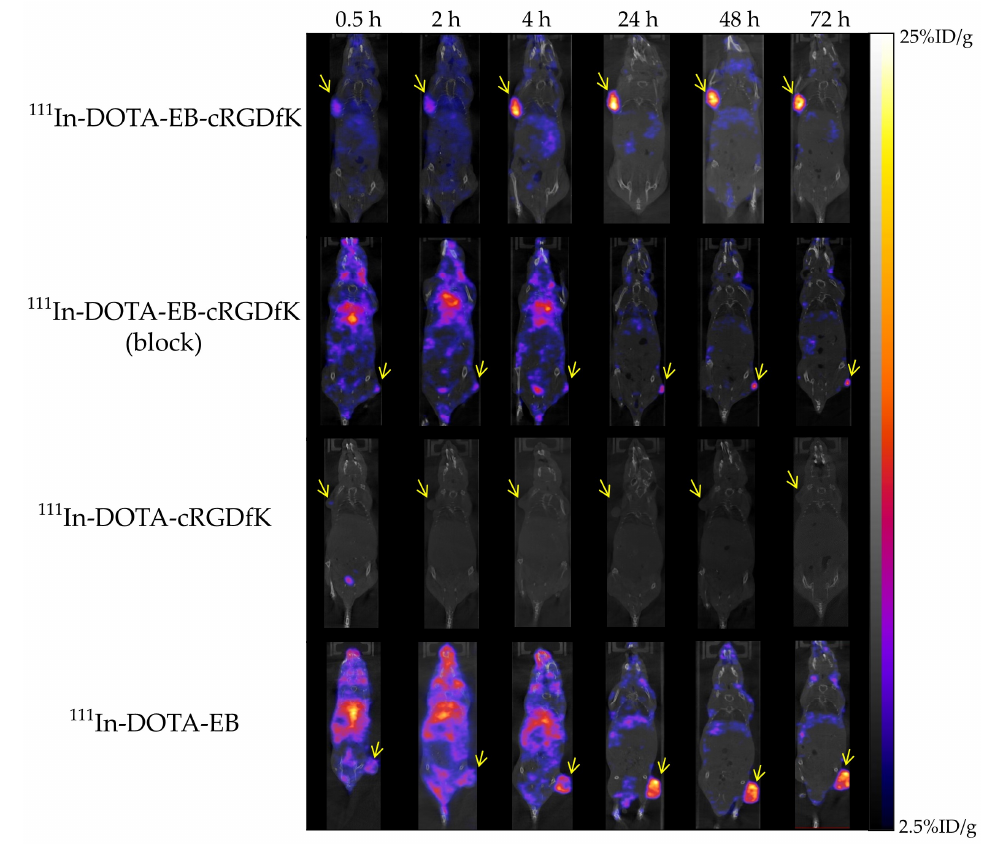
Figure 3. NanoSPECT/CT images of U-87 MG tumor-bearing mice. NanoSPECT/CT images at 0.5, 1, 4, 24, 48 and 72 h after injection of 111 In-DOTA-EB-cRGDfK, 111 In-DOTA-EB-cRGDfK with 120 times DOTA-EB-cRGDfK, 111 In-DOTA-cRGDfK and 111 In-DOTA-EB. Arrows indicate tumor location.